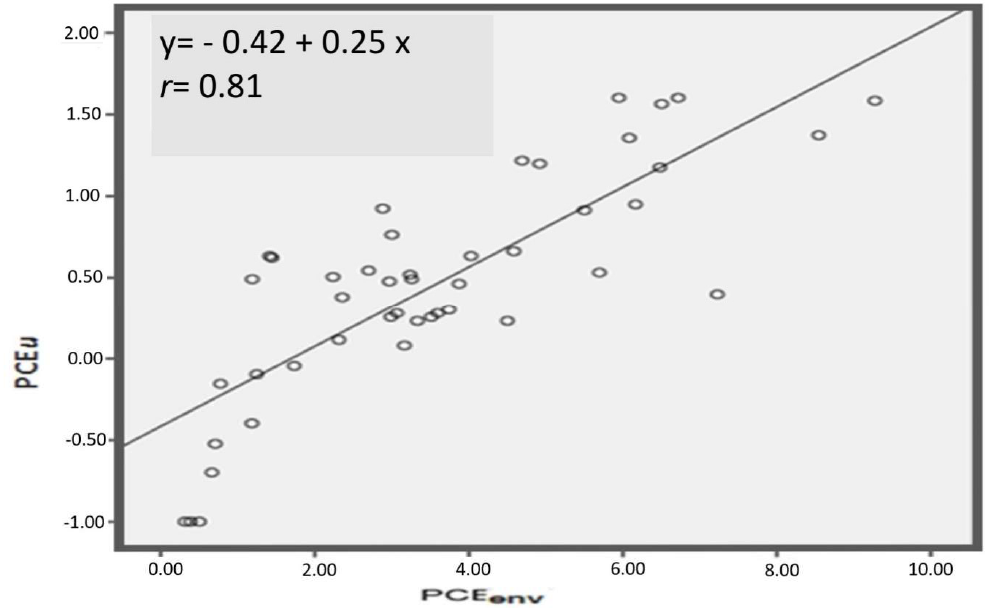
Figure 3. Correlation between environmental PCE concentration in the proximity of workers’ airways (PCE env , after square root transformation) and PCE concentration in the urines of the workers at the end of the work shift (PCE u after base-10 logarithm transformation). The regression line equation and the Spearman r coe ffi cient are also